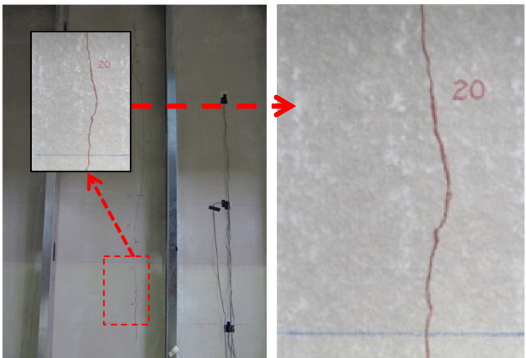
Figure 18. Location and detail of the fissured generated at the end of the load cycle 19. 6.